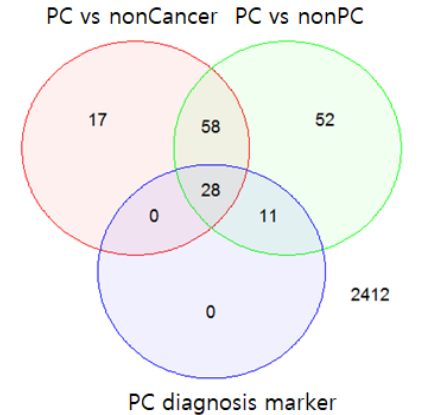
Figure 3. Venn diagram of the differentially expressed miRNAs and 39 selected diagnostic mark- ers. The top 39 miRNAs included 28 miRNAs that were differentially expressed between pancre- atic cancer (PC) samples and non-cancer samples (false discovery rate (FDR) < 0.05) and 11 miR-